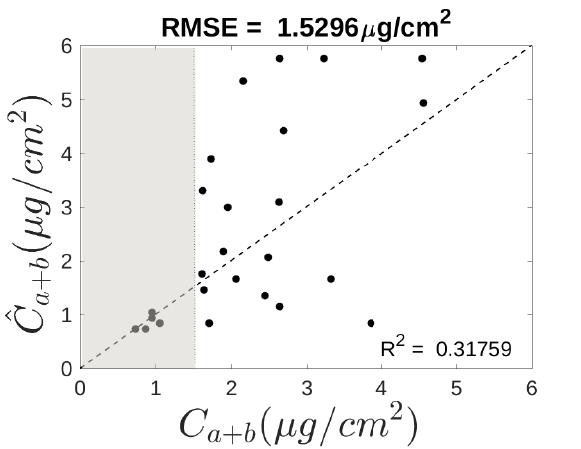
Figure 6. Estimated chlorophyll content, ˆ C a + b , with the BLR method as a function of the chlorophyll content, C a + b , in a real signature. The shaded area indicates the points that correspond to C a + b values less than 1.5 µg/cm 2